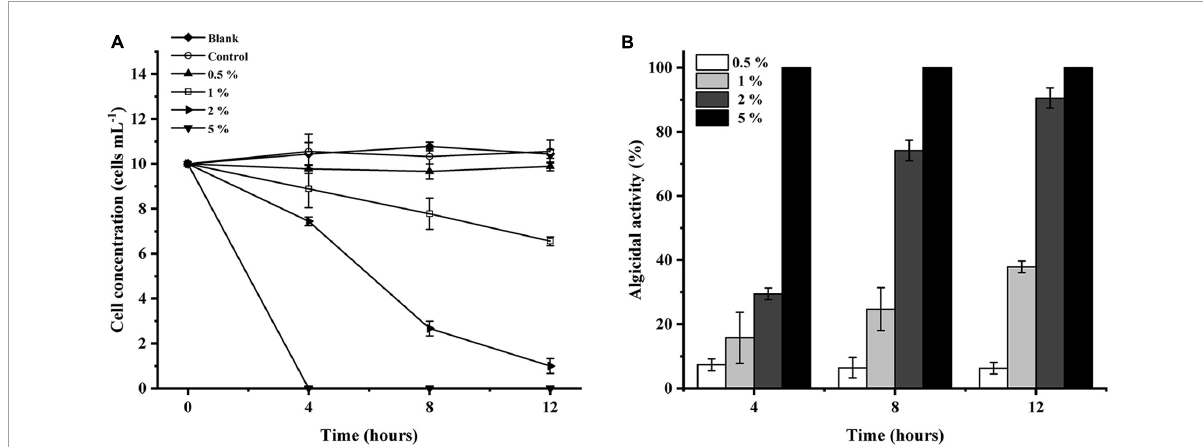
FIGURE3 Algicidal activities of different concentrations of LD-B6 culture on Noctiluca scintillans based on (A) algal cell concentration and (B) algicidal activity. The error bars represent standard deviations ( n = 3).